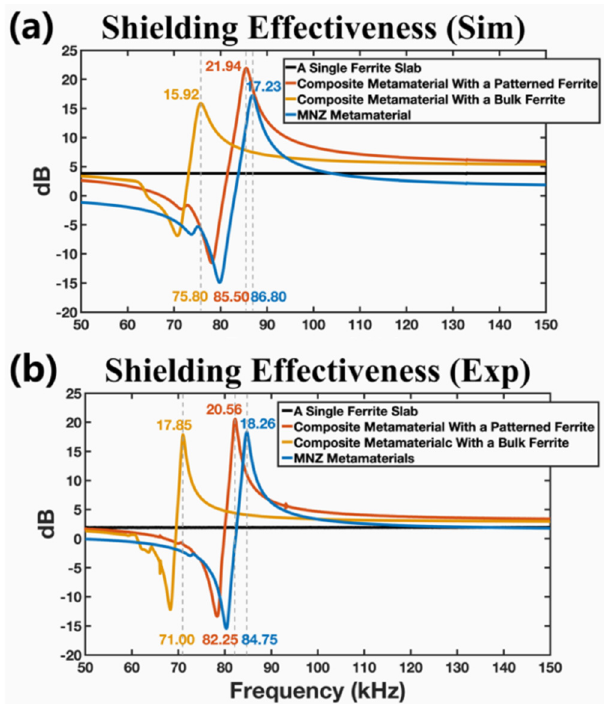
Fig. 5. (a) The shielding effectiveness (SE) obtained by simulation. (b) The SE obtained by